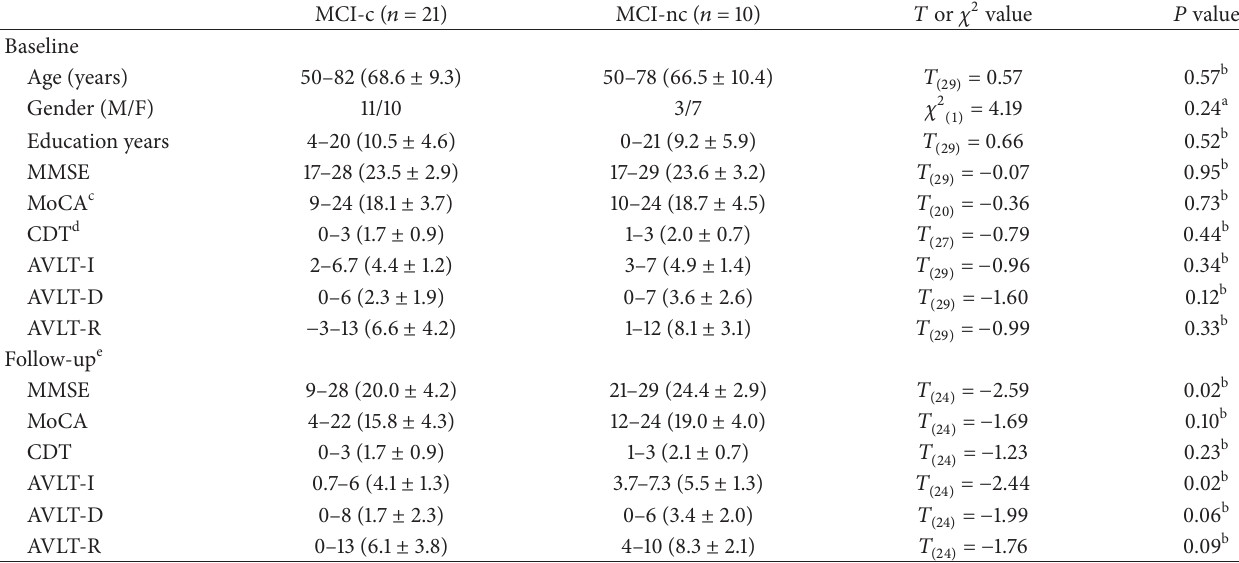
Table 2: Demographics and clinical characteristics of MCI-c and MCI-nc patients.